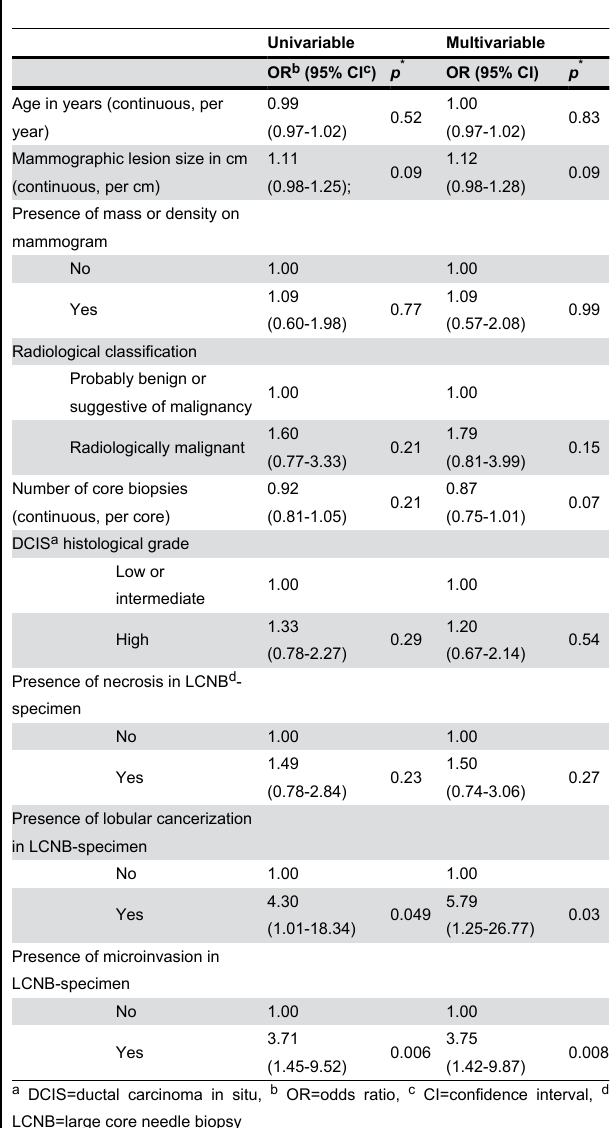
Table 3. Logistic regression analysis of preoperative predictors of DCIS a